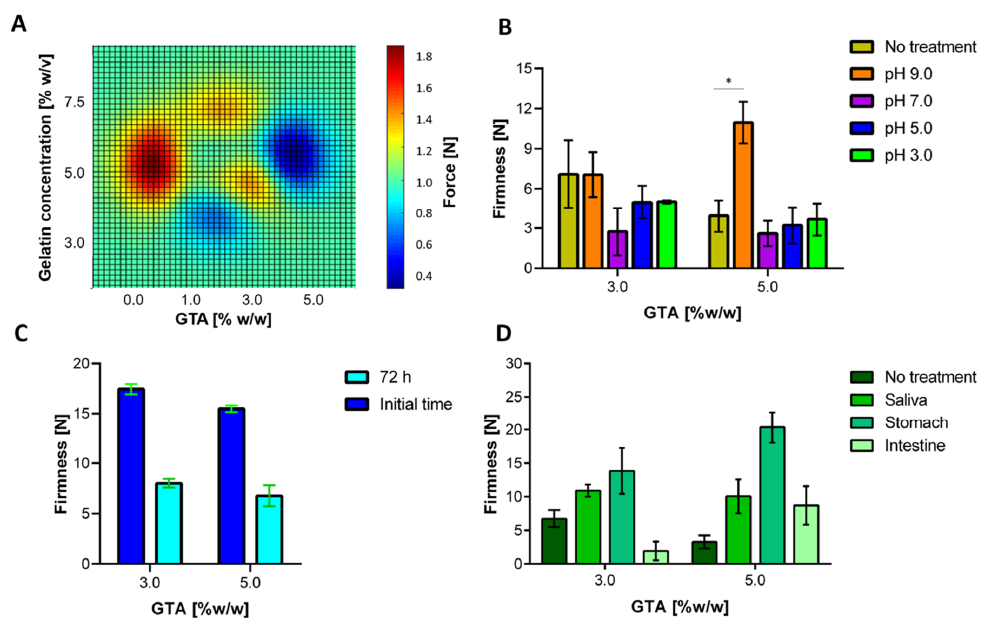
Figure 8. Evaluation of the mechanical response of hydrogels. ( A ) Breaking force for chemically crosslinked hydrogels. The subsequent results are related just to the two treatments selected for cell encapsulation. ( B ) Hydrogel firmness after exposure to media with di ff erent pH values. ( C ) Hydrogel firmness after the operation in the milli-bioreactor for 72 h. ( D ) Hydrogel firmness for the gastrointestinal tract simulated